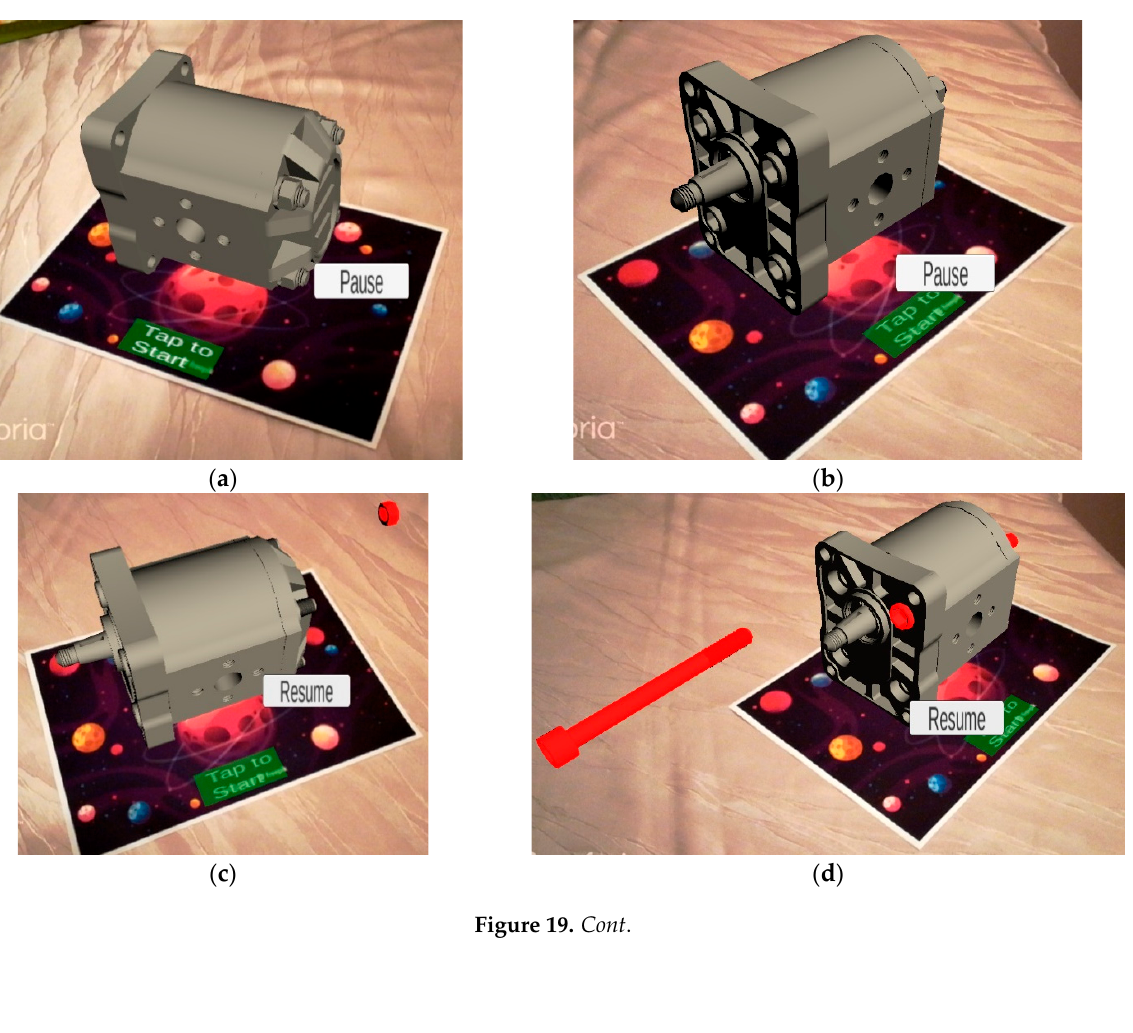
Figure 18. Script for the virtual button.